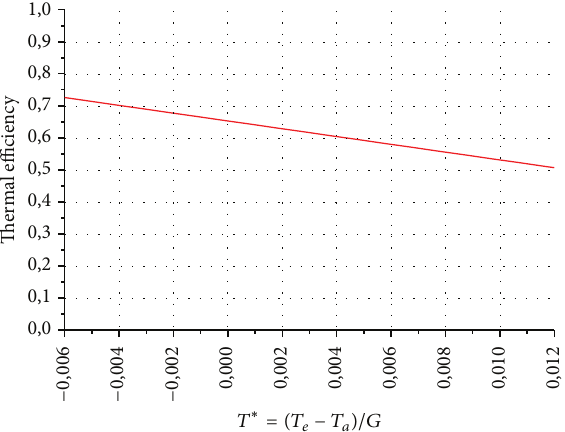
Figure 4: Thermal efficiency as a function of reduced temperature for the day of testing.